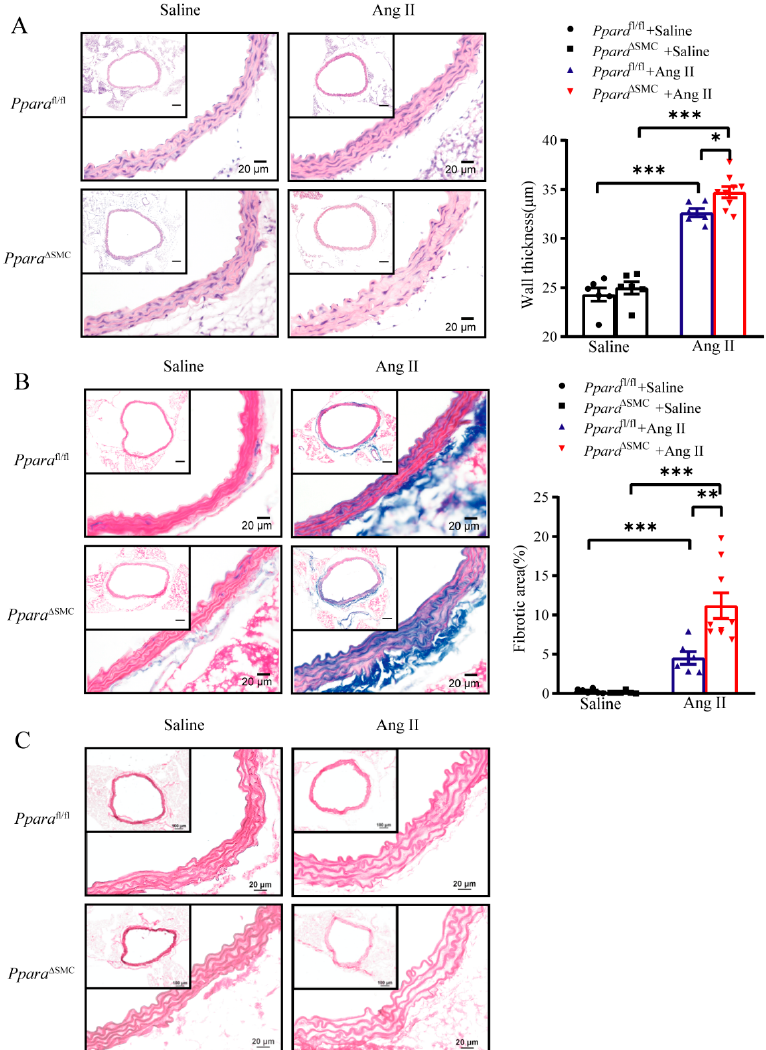
Figure 3. PPAR α deficiency in VSMCs aggravated Ang II − induced vascular remodeling ( A ) Repre- sentative images of hematoxylin and eosin-stained aortic cross sections are shown, aortic thickness was quantified. ( B ) Representative images of Masson’s trichrome-stained aortic cross sections are shown, and fibrotic area was quantified. ( C ) Representative images of Weigert’s elastin -stained aortic cross sections are shown ( n = 6–9, two-way ANOVA). Data are means ± SEM. * p < 0.05, ** p < 0.01, *** p < 0.01 between